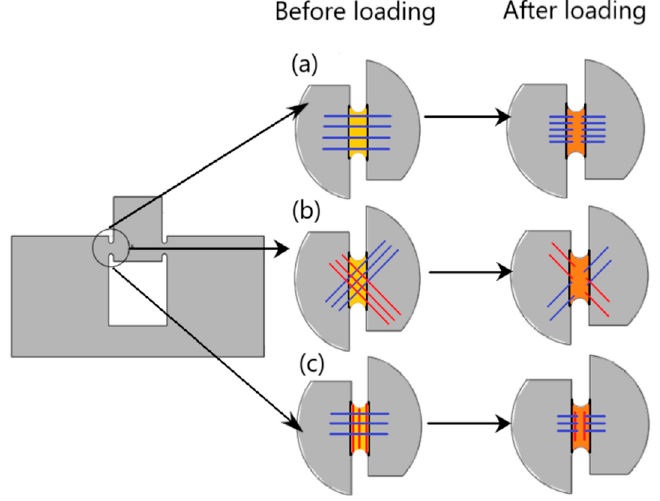
Figure 7. Schematic representation of filaments before and after loading for each raster orientation;